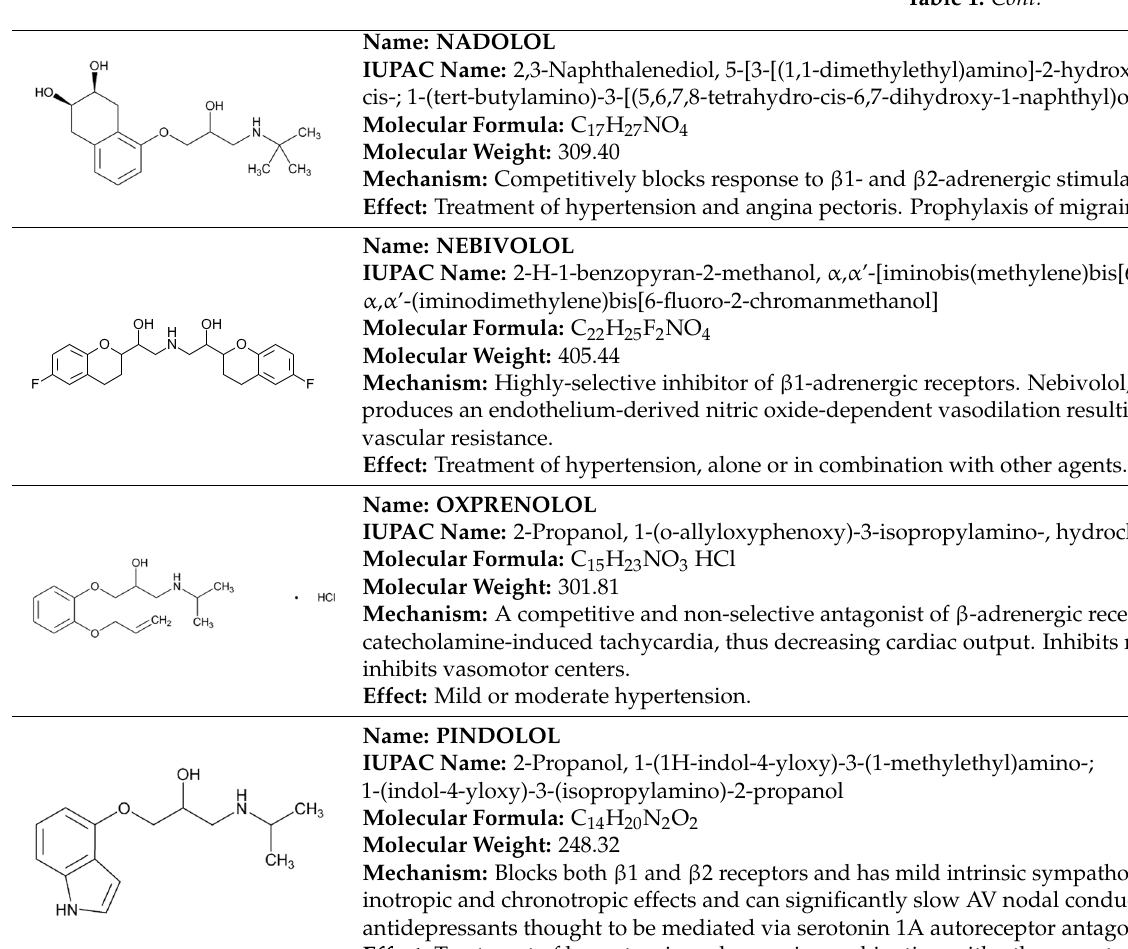
Molecular Formula: C 14 H 20 N 2 O 2 Molecular Weight: 248.32 Mechanism: Blocks both β 1 and β 2 receptors and has mild intrinsic sympathomimetic activity. Has negative inotropic and chronotropic effects and can significantly slow AV nodal conduction. Augmentative action of antidepressants thought to be mediated via serotonin 1A autoreceptor antagonism. Effect: Treatment of hypertension, alone or in combination with other